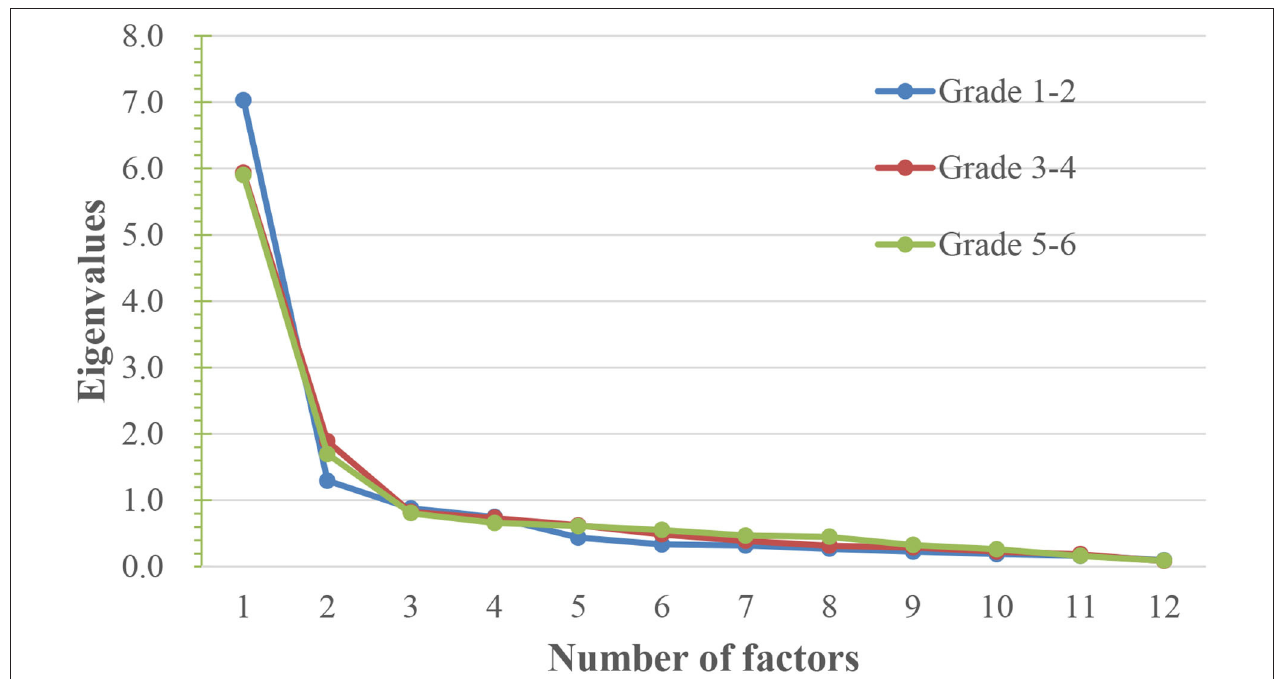
FIGURE 1 | Gravel diagram of factor